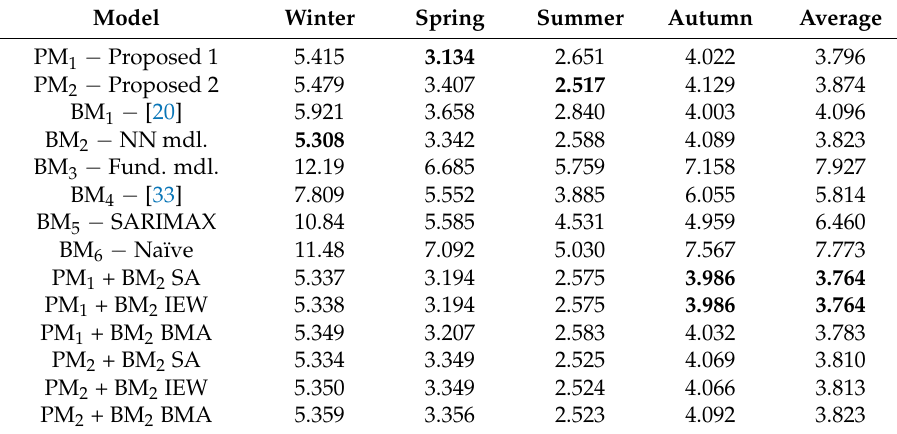
Table 5. Forecasting error in terms of RMSE ( €